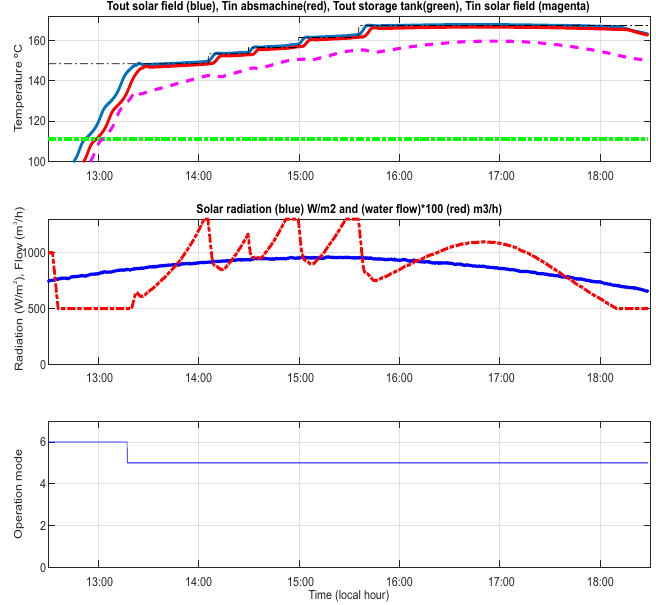
Figure 15. Operation modes in a clear